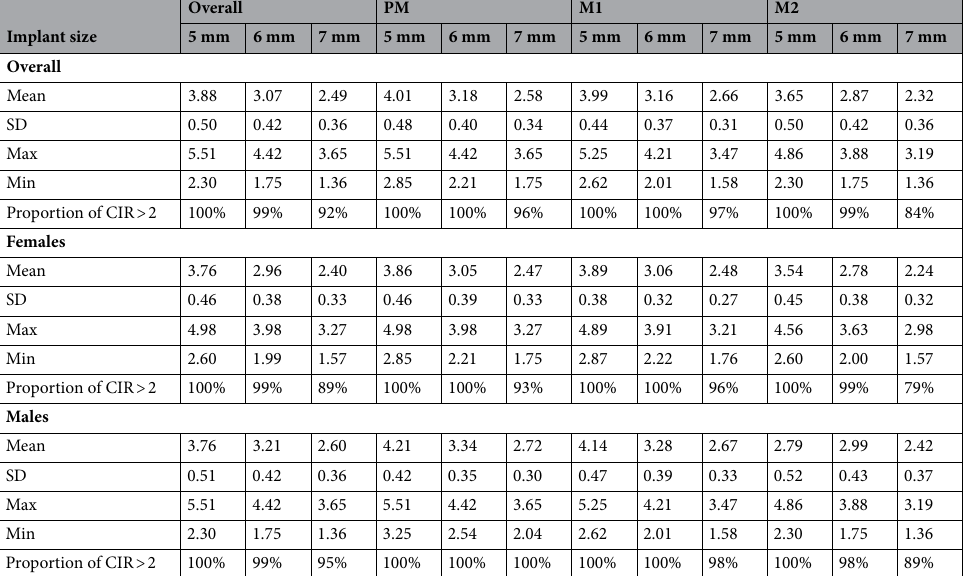
Table 5. Calculation of the crown-to-implant ratio (C/I R), by implant length. PM: second premolar. M1: first molar. M2: second molar.